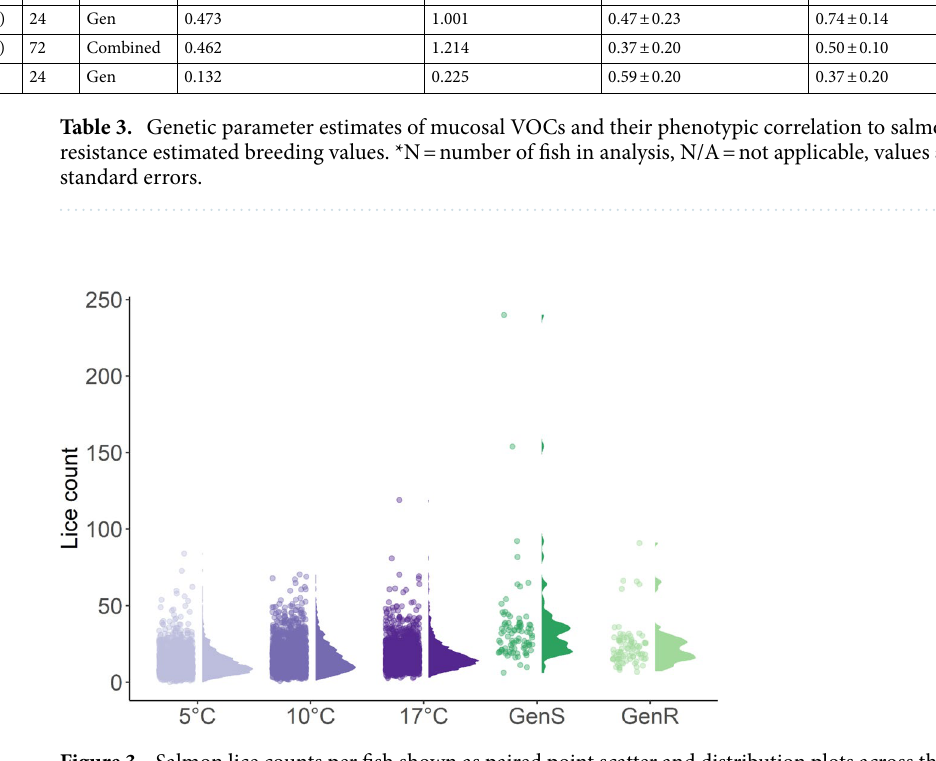
Figure 3. Salmon lice counts per fish shown as paired point scatter and distribution plots across the three water temperature groups (5 °C, 10 °C, 17 °C) in the Temp trial (shades of purple following temperature gradient) and the susceptible strain (GenS in dark green) and resistant strain (GenR in light green) in the Gen